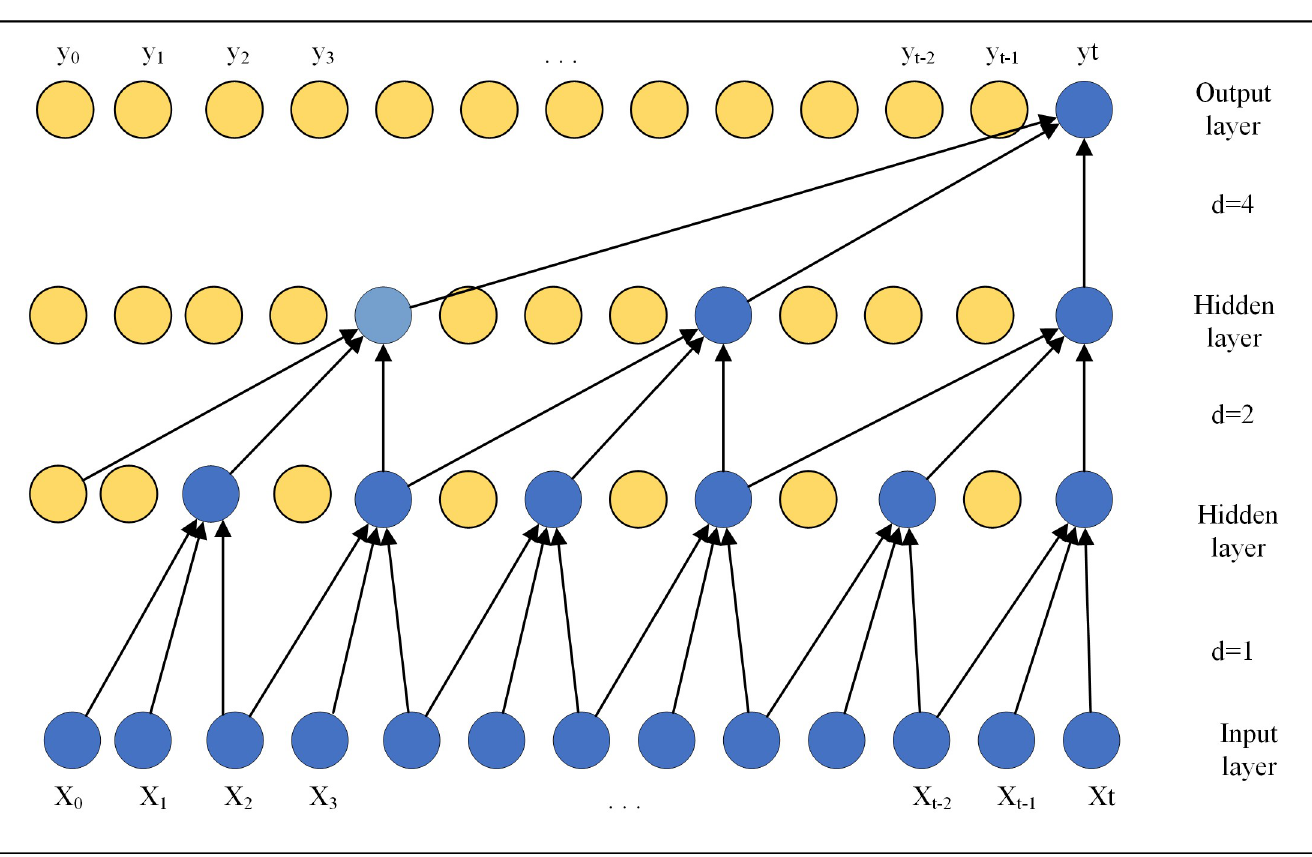
Fig 3. Dilated convolution